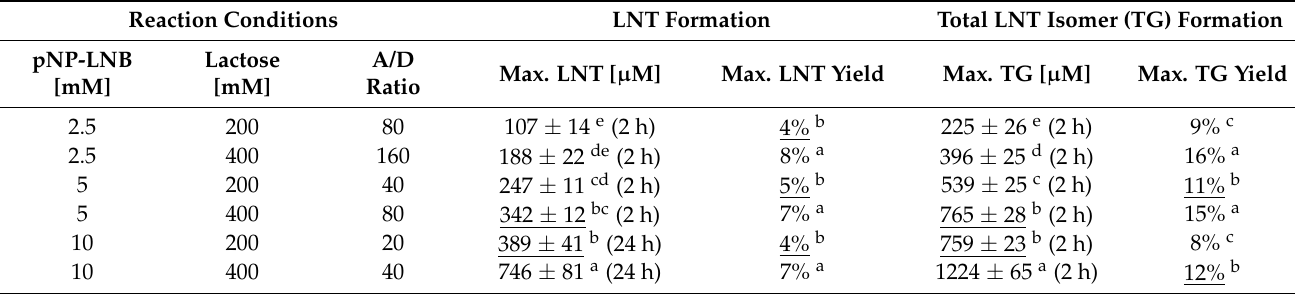
Table 3. Optimization of substrate concentrations for the transglycosylation reaction with LnbB W394H using pNP-LNB as donor substrate (D) and lactose as acceptor substrate (A) at pH 4.5 and 30 ◦ C with 1 µ M of enzyme. Product concentrations and molar yield (calculated on donor substrate) of LNT and of LNT plus isomers (total transglycosylation products; TG) are given, with the time at which the maximum yield is reached given in brackets (monitored over 24 h). Superscript letters ( a–e ) indicate statistically significant difference between the values within the column ( p < 0.05). Reaction Conditions LNT Formation Total LNT Isomer (TG)